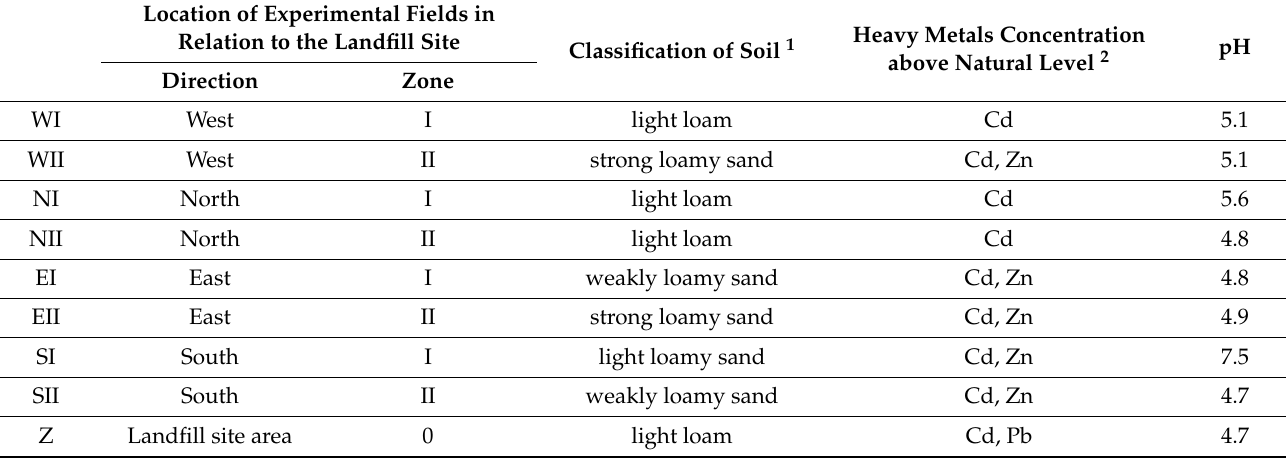
Table 1. Characteristic of soil at the plots near the municipal landfill